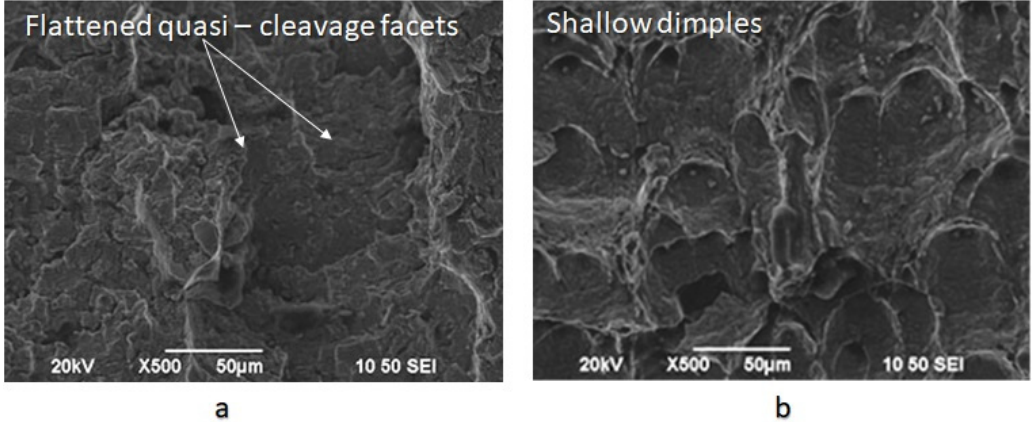
Figure 17. Fractured surfaces after CTOD testing of X65 steel for the uncharged condition ( a ) fatigue pre-cracked area; ( b ) bended area.